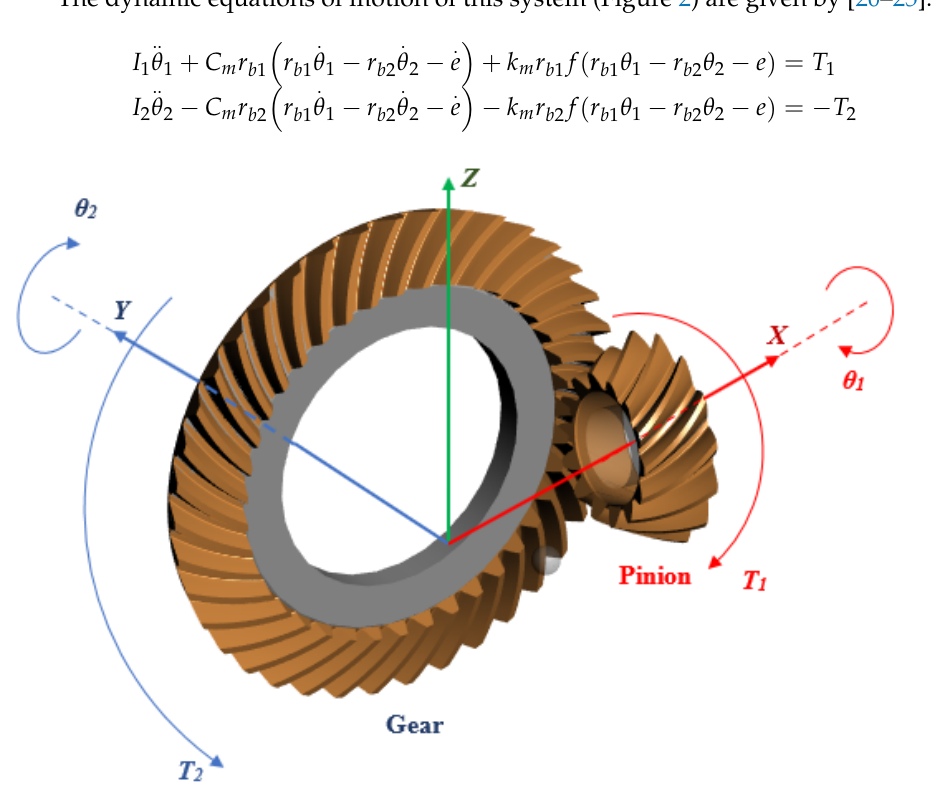
Figure 2. The dynamic model of a gear system with rotational degrees of freedom. Due to mounting and manufacturing error or teeth profile modifications, the backlash between mating teeth varies; it is called geometric transmission error, or e(t). The linear dynamic transmission error (DTE) along the line of action is defined as λ = r b1 θ 1 − r b2 θ 2 . Let n = r b2 / r b1 , the speed ratio. The two equations are merged, and the following equation is obtained.